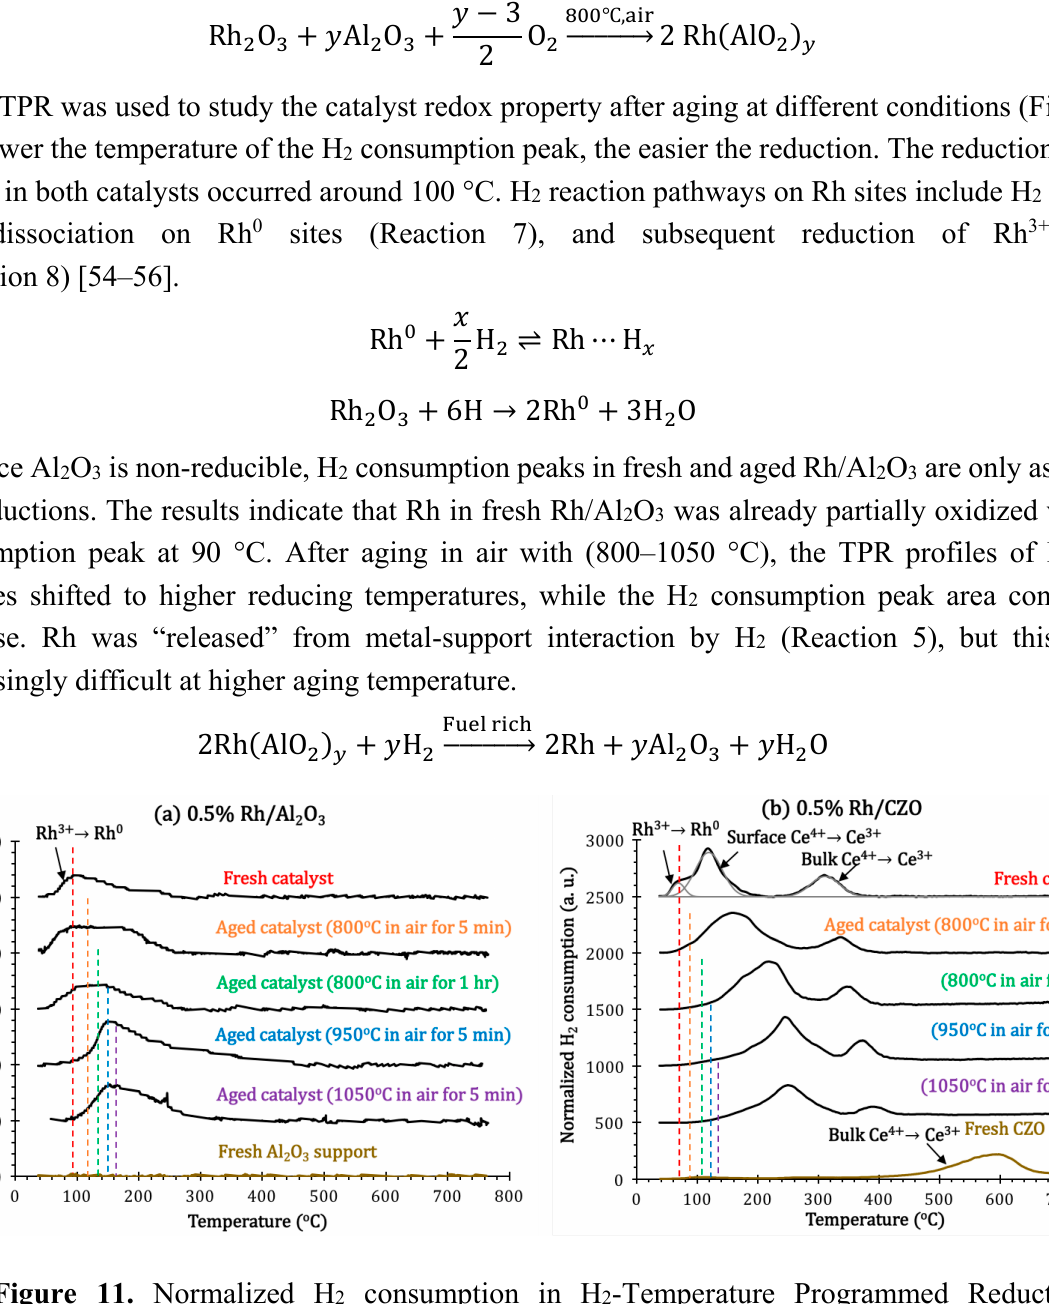
Figure 11. Normalized H 2 consumption in H 2 -Temperature Programmed Reduction (H 2 -TPR) measurements of fresh and aged ( a ) 0.5% Rh/Al 2 O 3 and ( b ) 0.5% Rh/CZO, as a function of reducing temperature. Aged samples for measurements were respectively achieved by aging the fresh ones in air at the following conditions: 800 °C for 5 min, 800 °C for 1 h, 950 °C for 5 min, or 1050 °C for 5